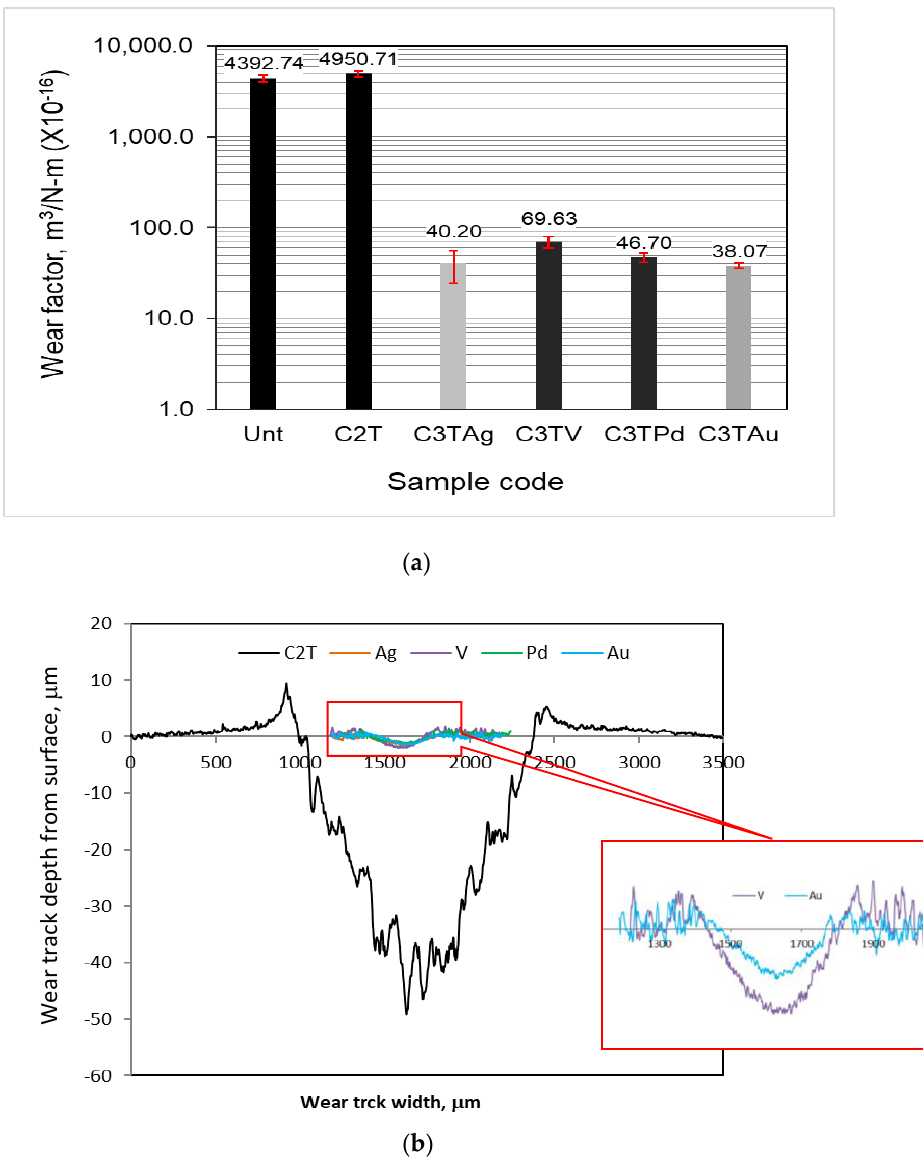
Figure 8. ( a ) Wear factors and ( b ) 2D wear track profiles of untreated and 600 °C10 h treated samples with and without pre-deposition layers (inserted details of the enlarged wear tracks of C3TV and C3TAu samples).